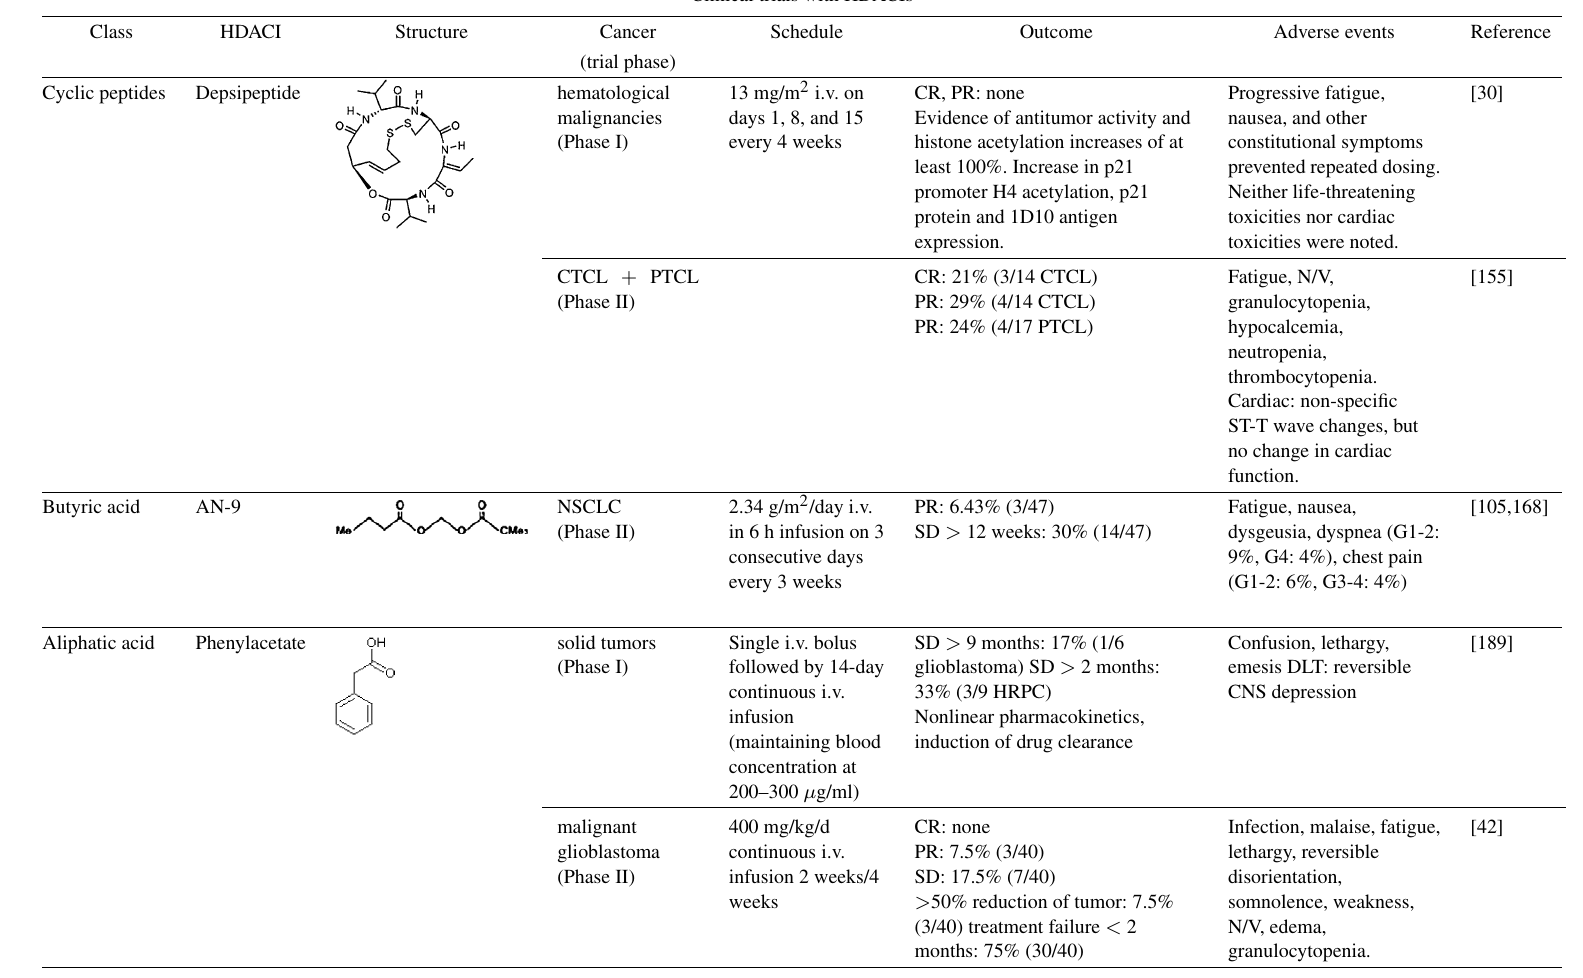
Clinical trials with